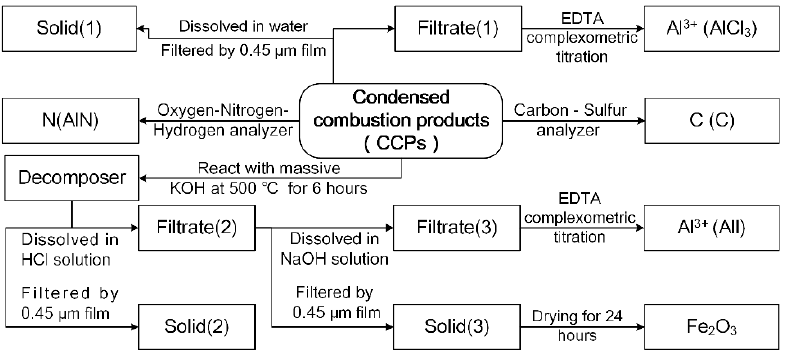
Figure 4. Chemical analysis scheme for CCPs.